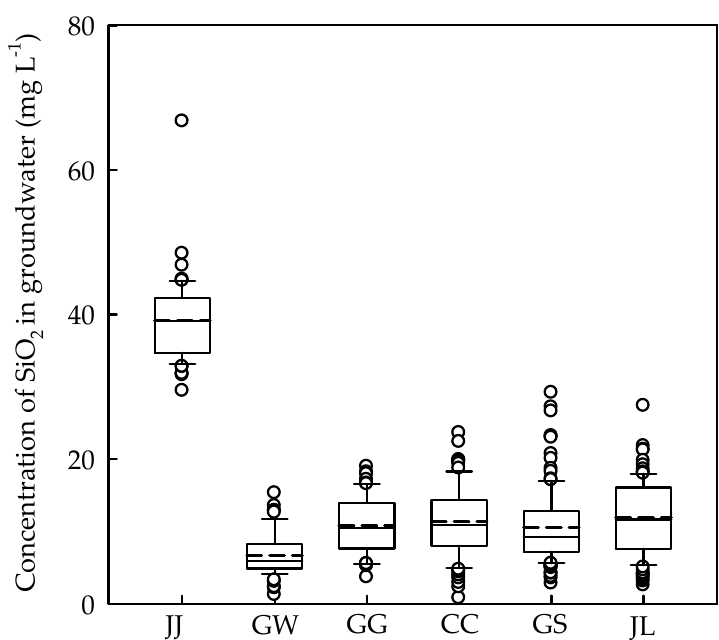
Figure 2. Box plots of SiO 2 concentration in groundwater of South Korea. JJ: Jeju Island, GW: Gangwon province, GG: Gyeonggi province, CC: Chungcheong province, GS: Gyeongsang province, JJ: Jeolla province. Boxes represent 25th, 50th (median), and 75th percentiles, and the whiskers indicate the minimum and maximum values. Mean values (dashed line); outliers (o).